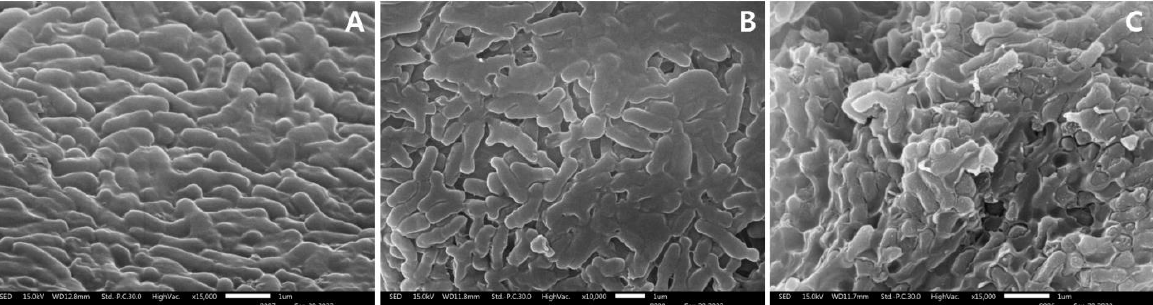
Figure 5. Scanning electron microscopy showing morphological changes in B. breve TISTR 2130 free cells without exposure to the simulated gastrointestinal conditions ( A ), after exposure to SGJ for 1 h ( B ), and after sequential exposure to SGJ for 1 h and SIJ for 4 h at 37 °C under anaerobic conditions ( C ).